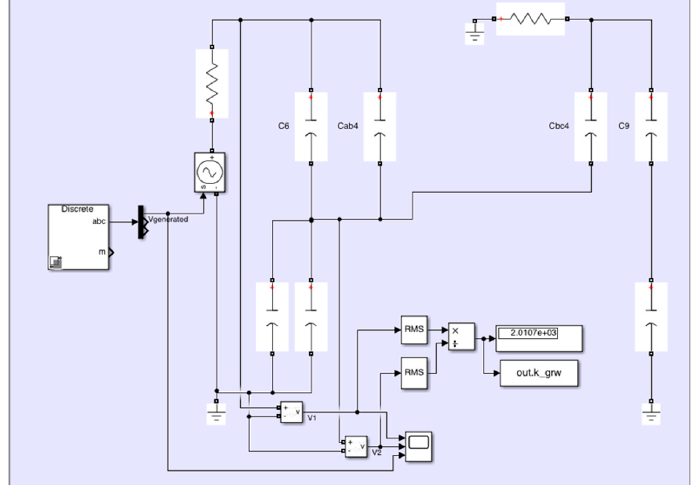
Figure 7. Screenshot of the equivalent circuit model developed with the Simulink environment.